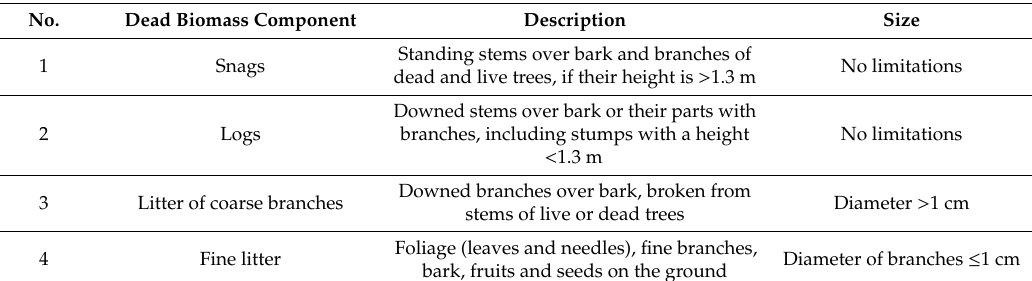
Table 4. Definitions of forest dead biomass components.